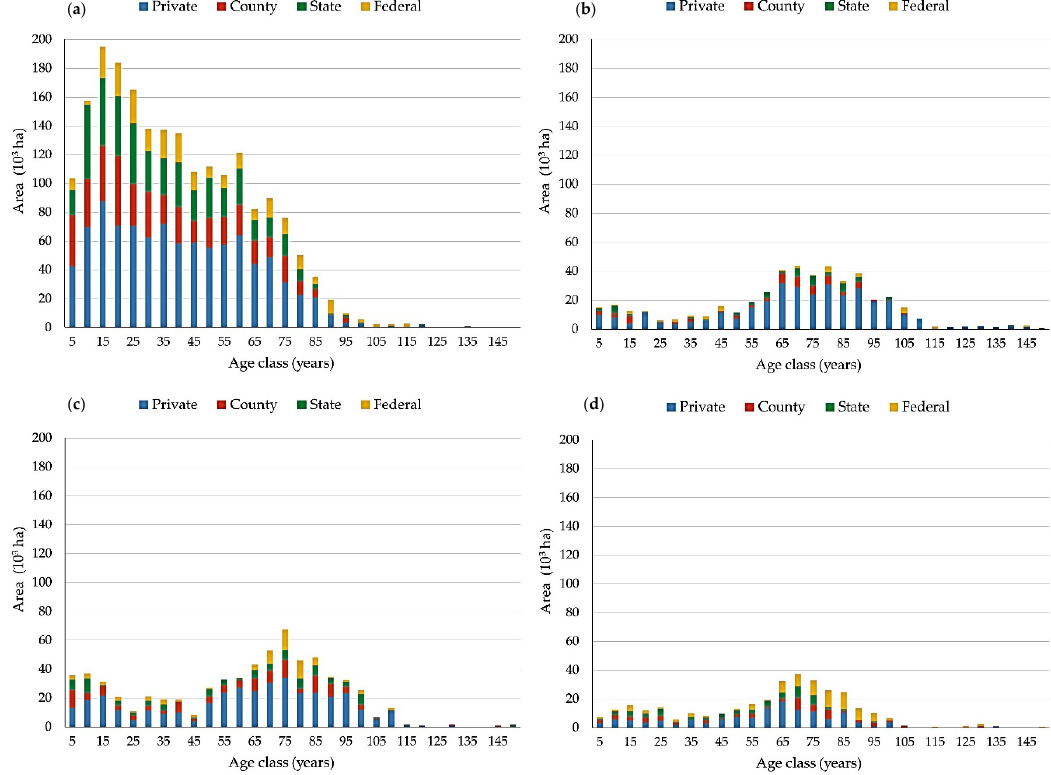
Figure 3. Current age-class distribution of aspen ( a ), oak ( b ), northern hardwoods ( c ), and paper birch ( d ) cover type timberland at the beginning of the planning horizon (period 0) in the study area.